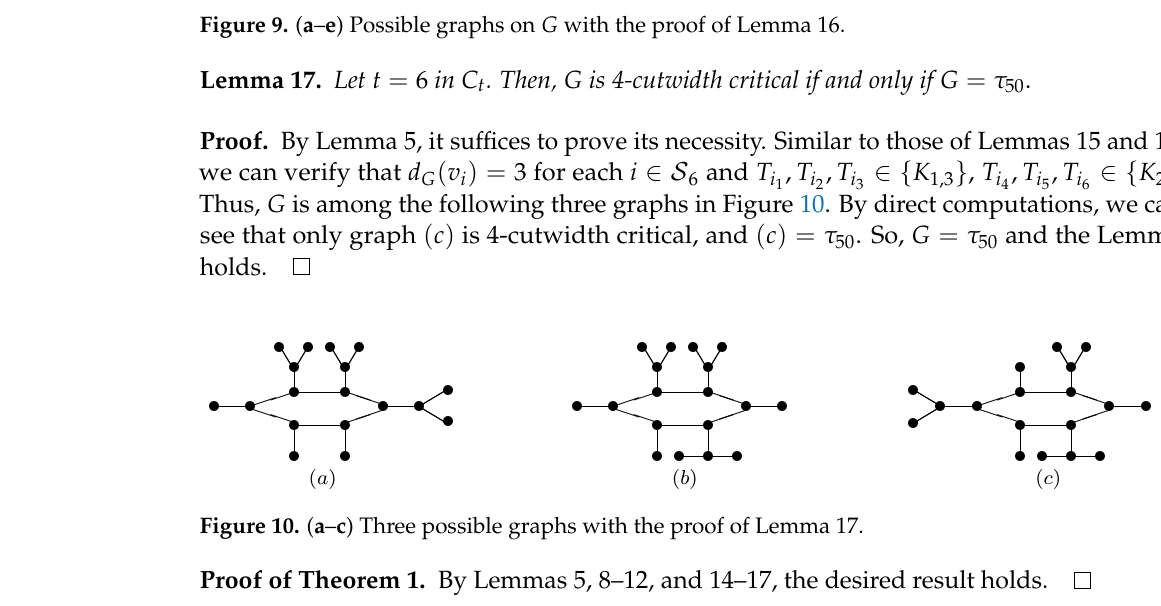
Fig.9. Possible graphs on G with the proof of Lemma 3.13 Figure 9. ( a – e ) Possible graphs on G with the proof of Lemma 16.